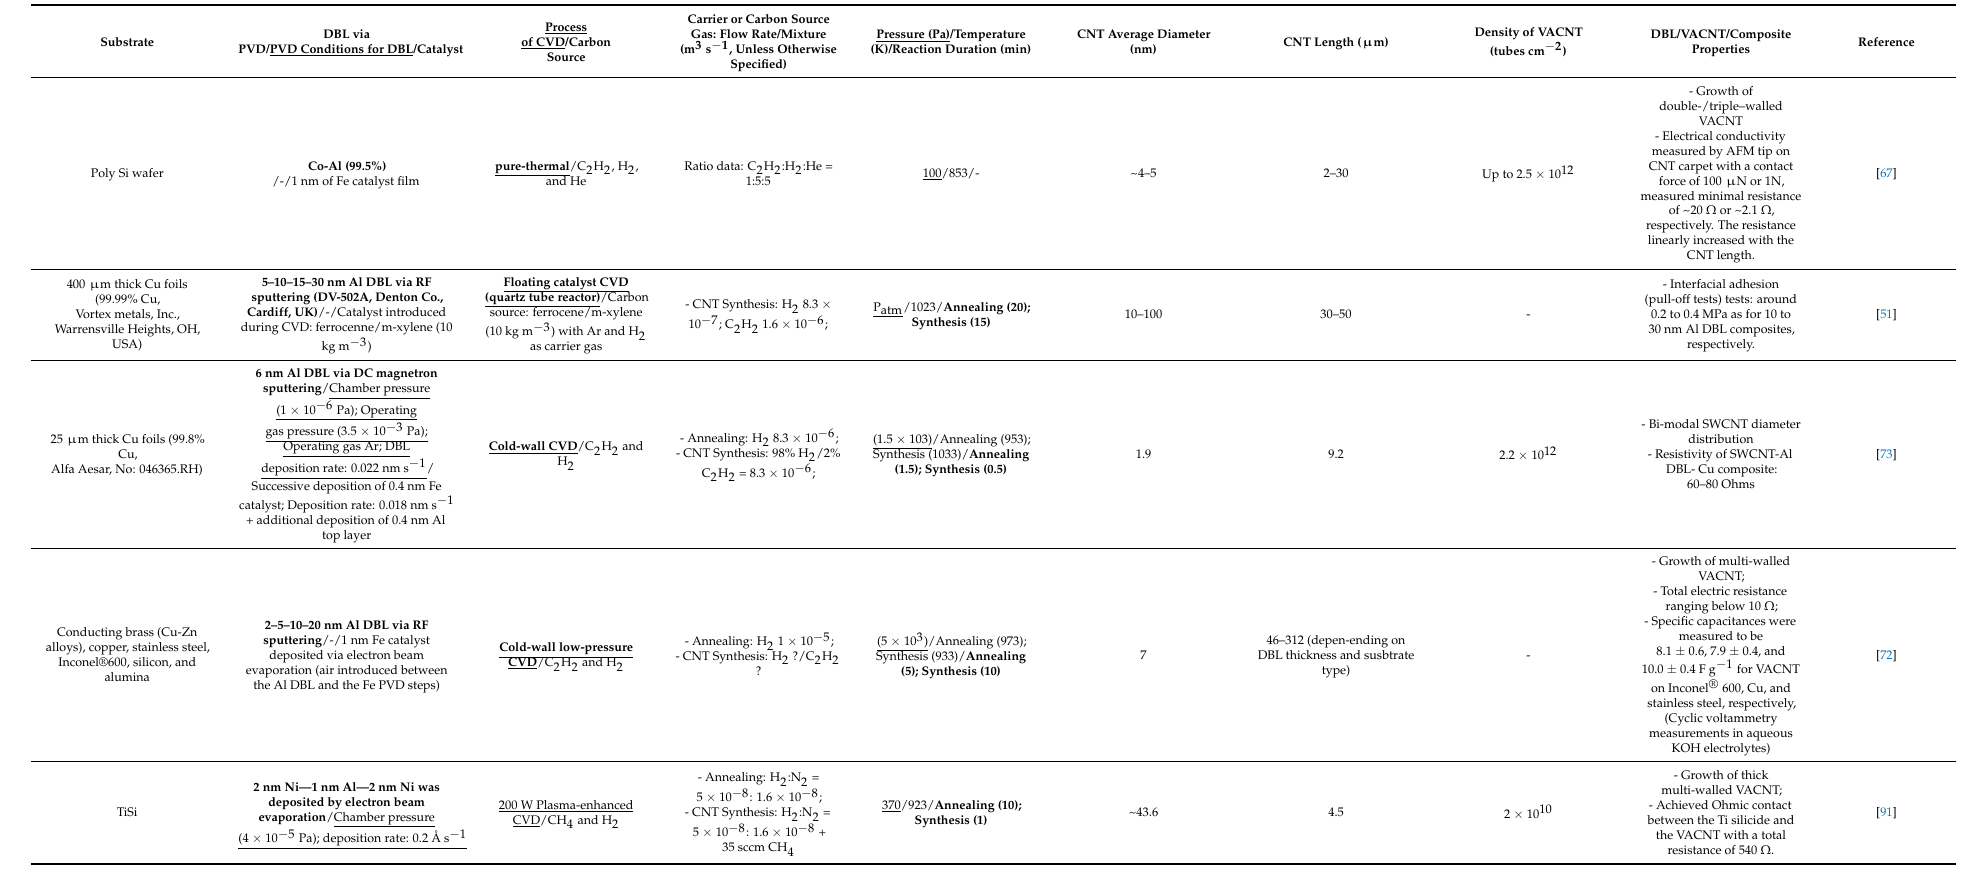
Table 2. Details of used substrate, lone or modified Al DBL (deposited via PVD), and VACNT growth conditions and